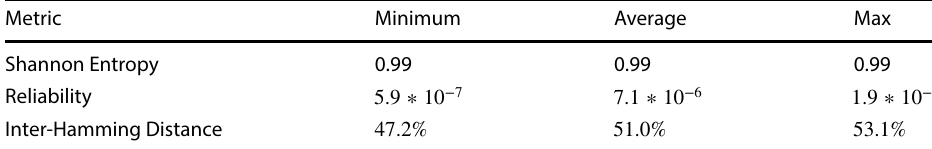
Table 1 PUF entropy, reliability, and